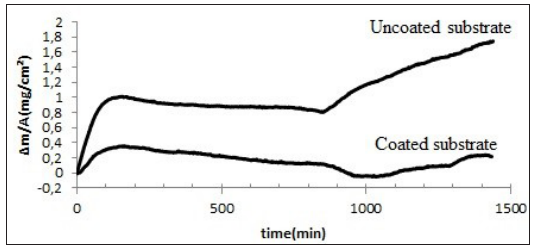
Figure 4. TGA curves of the coated heat-treated substrate and uncoated substrate at 800°C for 24 h in